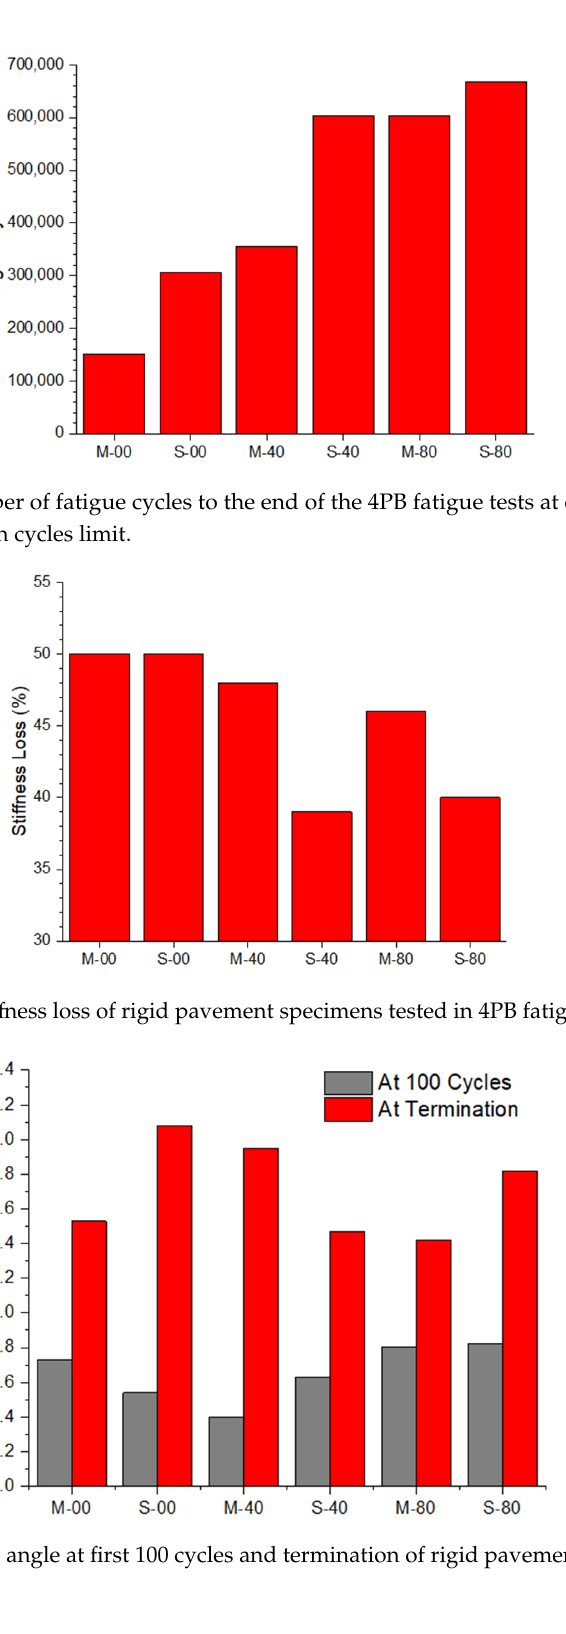
Figure 5. Stiffness modulus of the rigid pavement specimens at the start and the end of the 4PB fatigue tests.